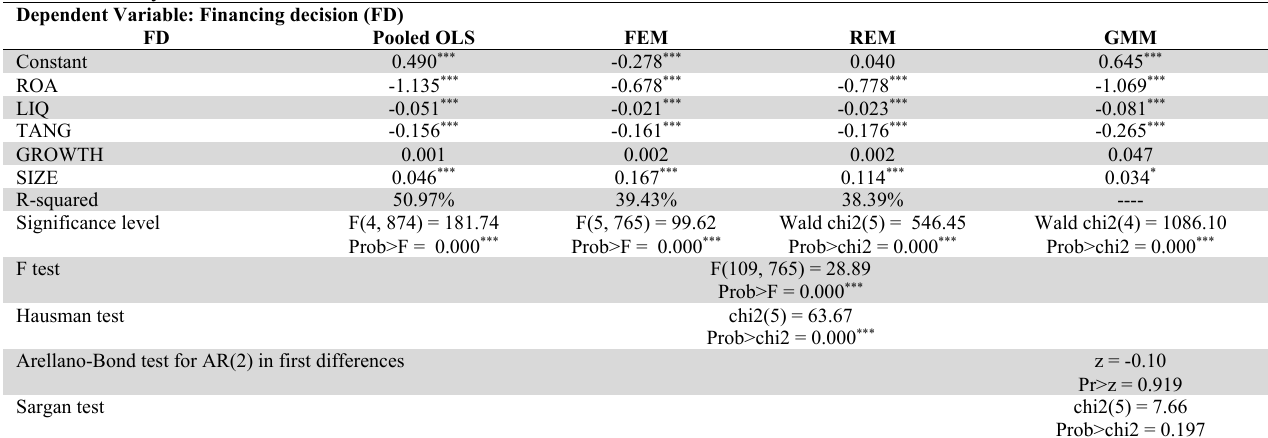
Results of study model estimation